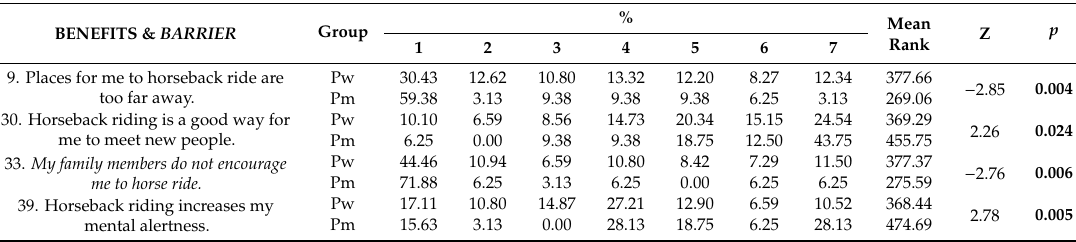
Table 9. Comparison of professional group based on gender: women (n = 713) vs men (n = 32), ( p < 0.05). (1–7 Likert scale: 1—this issue concerns me to a very low degree; 7—this issue concerns me to a very high